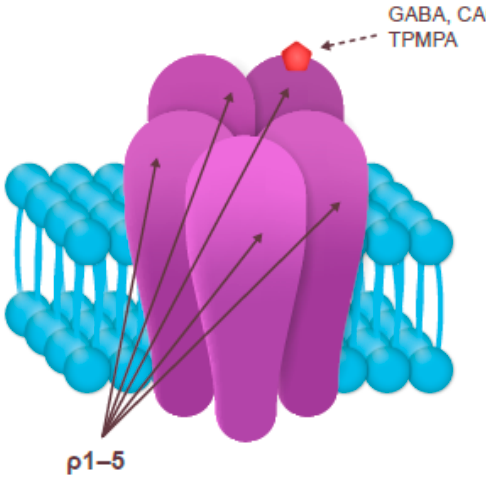
Figure 3. The structure and the ligand-binding site of the GABA C receptor [41]. CACA, cis-4- aminocrotonic acid; GABA, gamma-aminobutyric acid; ρ 1–5, GABA C ρ subunits 1–5; TPMPA, (1,2,5,6-tetrahydropyridin-4-yl) methylphosphinic acid. (1,2,5,6-tetrahydropyridin-4-yl) methylphosphinic